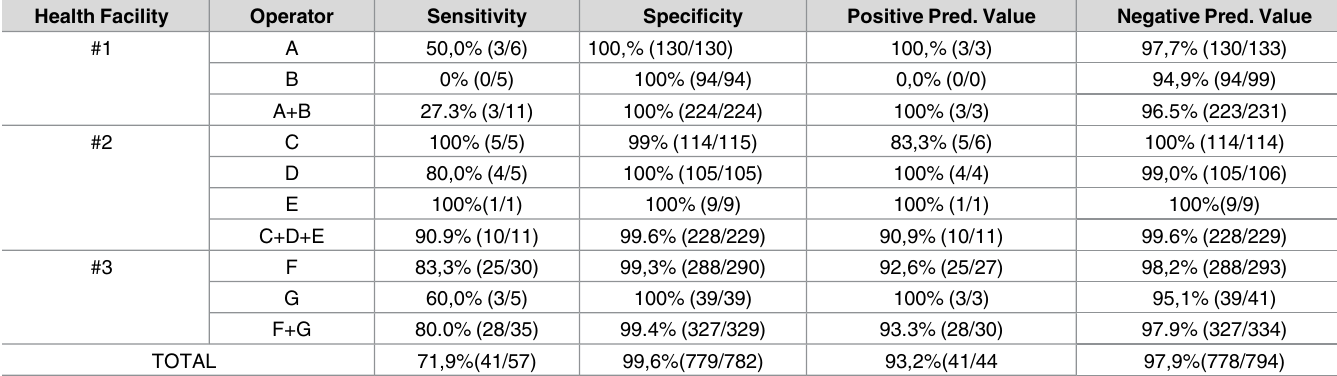
Table 2. Performanceof the Lynx POC EID p24 Ag test by health care facility and operator.